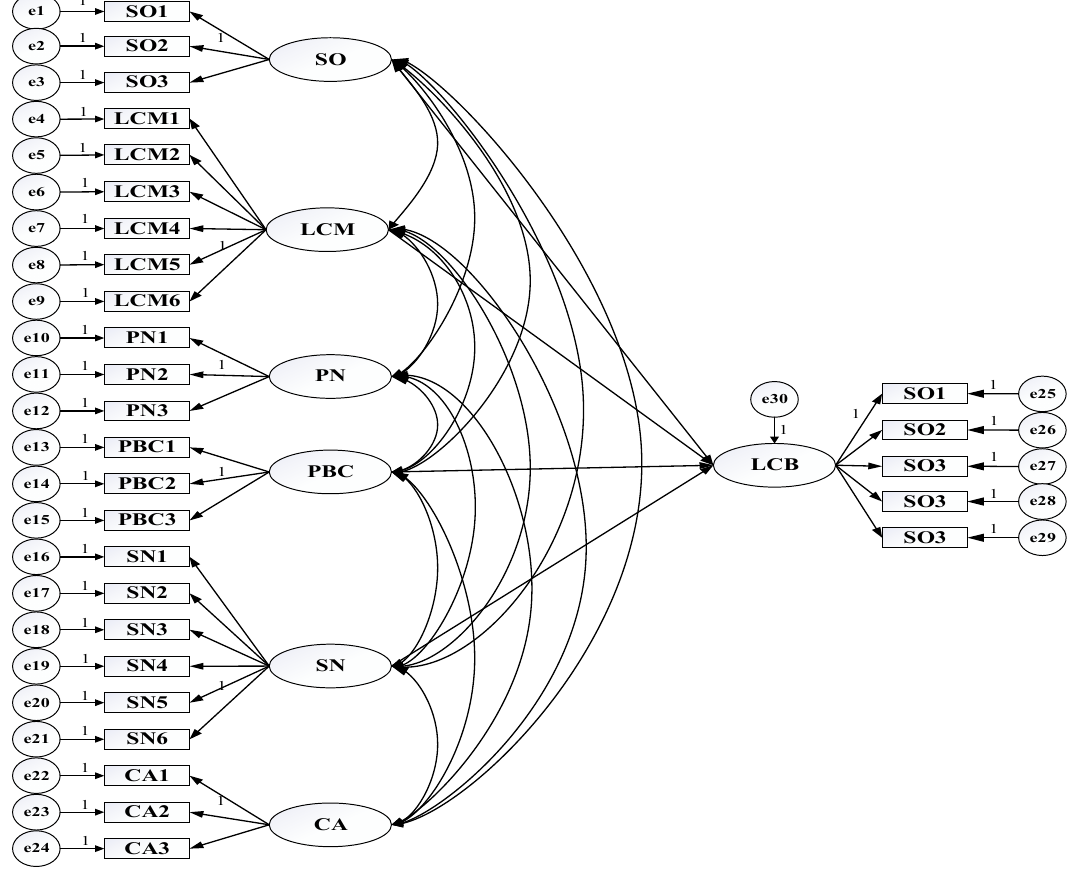
Figure 4. The initial structural model (M1).